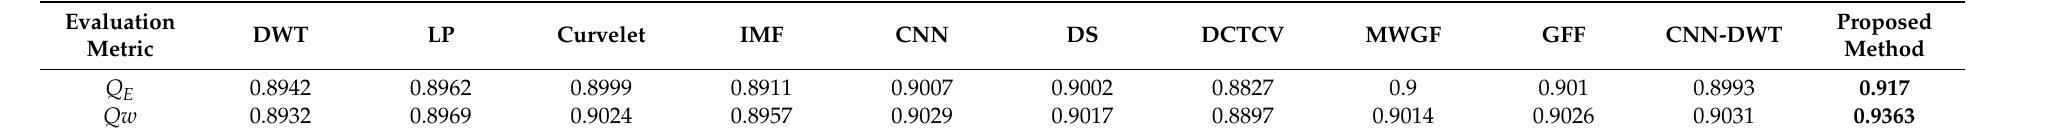
Table 19. The outcomes for the book image and comparisons with existing techniques in the litera- ture ([26]).